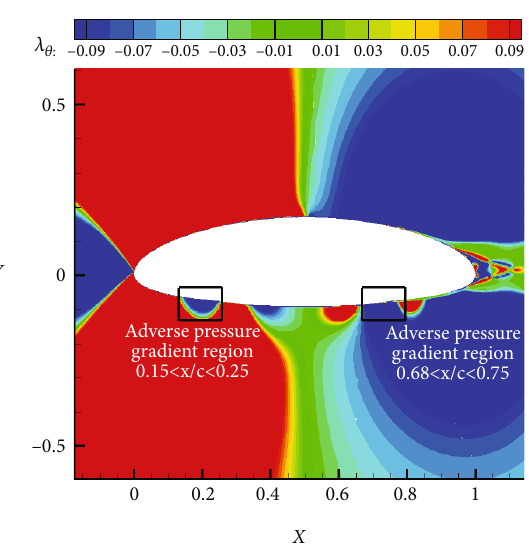
Figure 23: Transition onset position (upper surface).